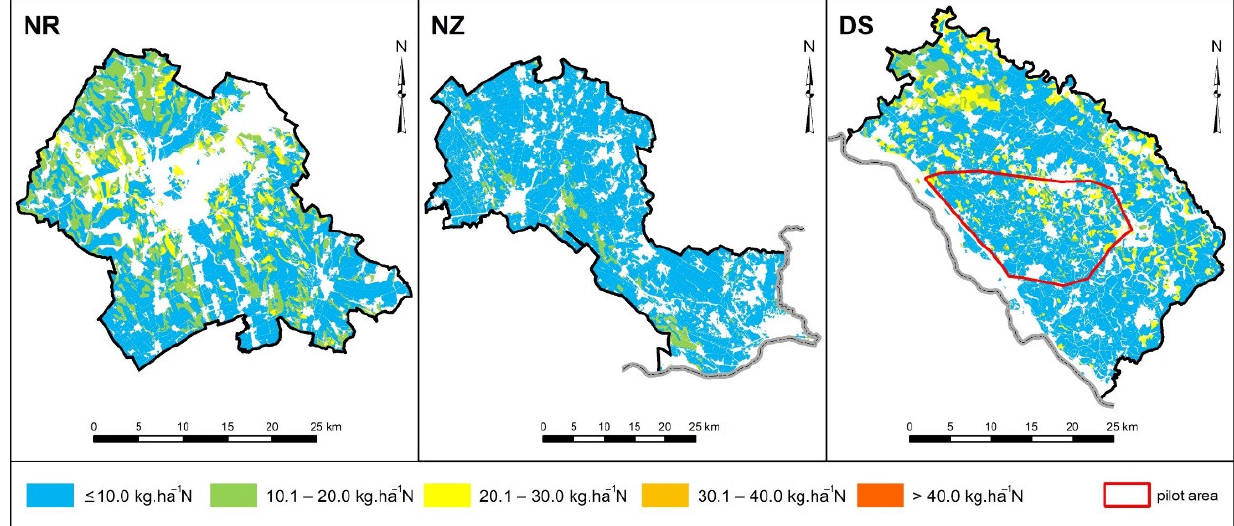
Figure 6. The amount of leachable nitrogen within UAL of selected districts. The amount of percolation water within UAL of selected districts (see Figure 7) corresponds to typical annual values up to 200 mm, which occur at precipitation totals around 600 mm in areas with warm climate.